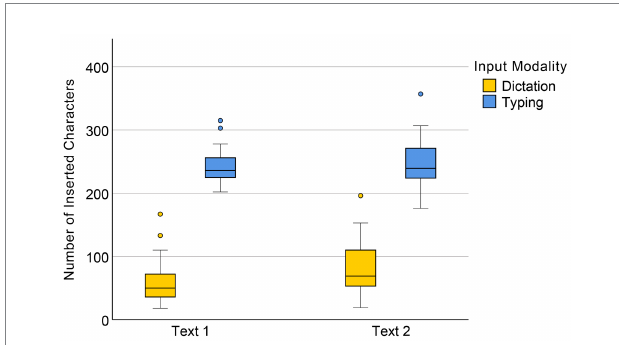
FIGURE 5 Numbers of inserted characters in dictation and typing conditions.